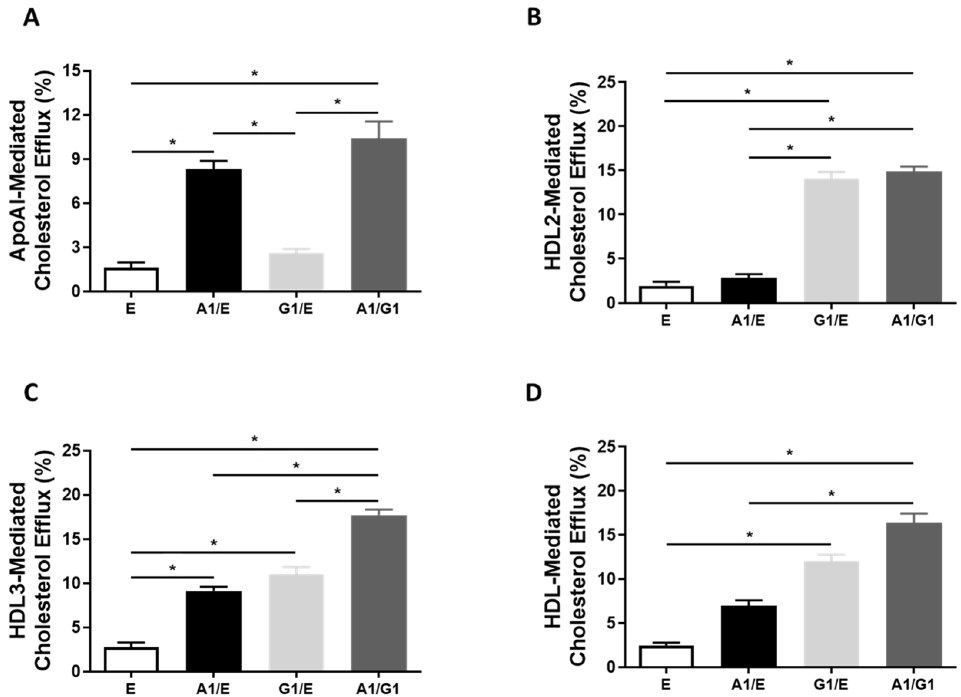
Figure 3. Enhanced cholesterol acceptor-mediated efflux in cultured 293-Cre cells constitutively expressing ABCA1 and ABCG1. ( A – D ) Cholesterol efflux measured in [ 3 H] cholesterol-loaded 293-Cre cells transfected with either empty vector plasmid (E), ABCA1-LSL plasmid and empty vector plasmid (A1/E), ABCG1-LSL plasmid and empty vector plasmid (G1/E), or ABCA1-LSL and ABCG1-LSL plasmids (A1/G1), and incubated with either apoAI ( A ), HDL2 ( B ), HDL3 ( C ), or heterogenous HDL ( D ) particles. Three independent experiments with three biological replicates per treatment for each experiment. Data are mean ± SEM. Asterisks (*) indicate statistical significance ( p < 0.05).